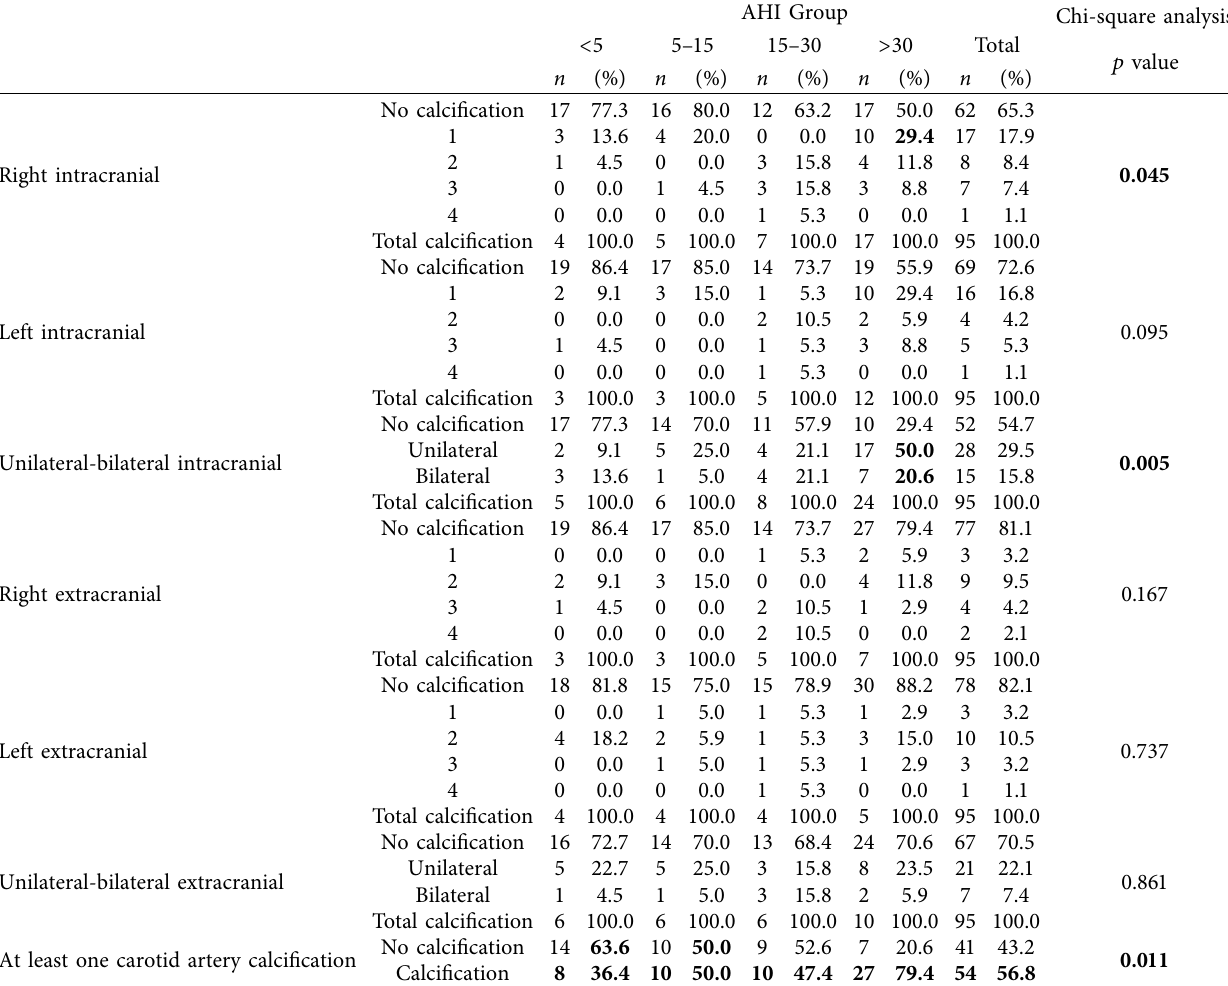
Table 4: Statistical analysis of carotid artery calcifications among OSA patients according to AHI groups. AHI Group Chi-square